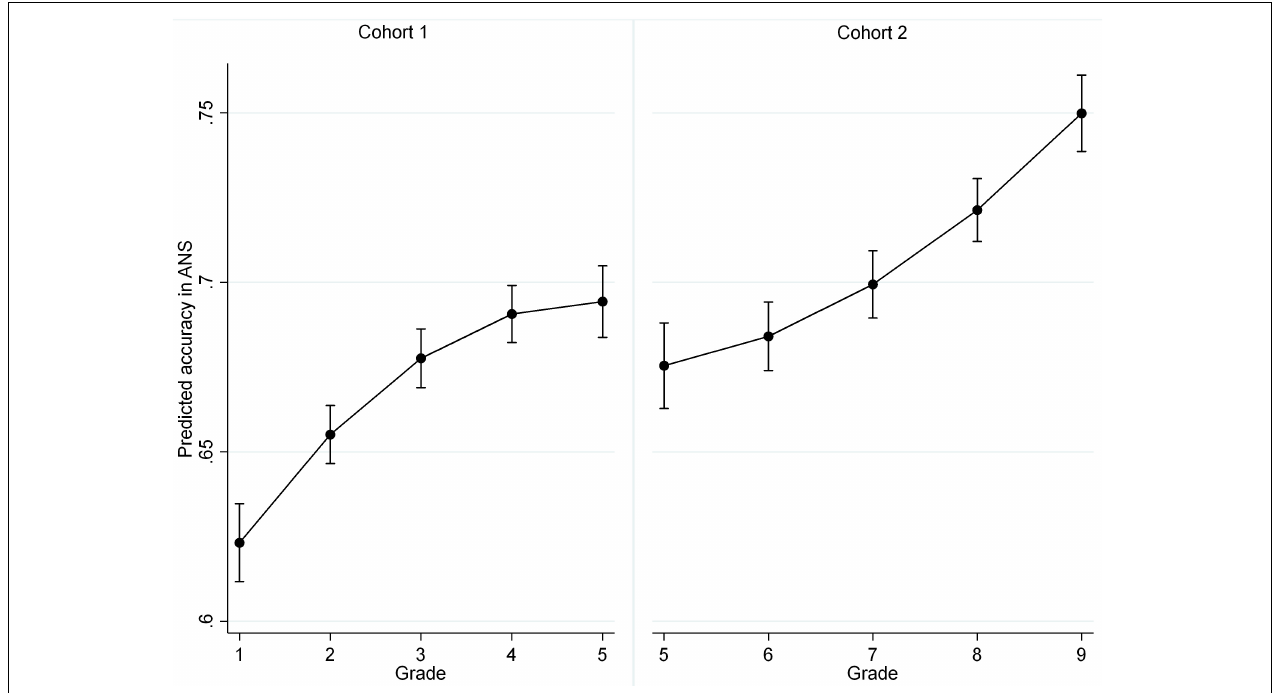
FIGURE 1 | Average predicted trajectories of changes in ANS accuracy for two cohorts (with 95%